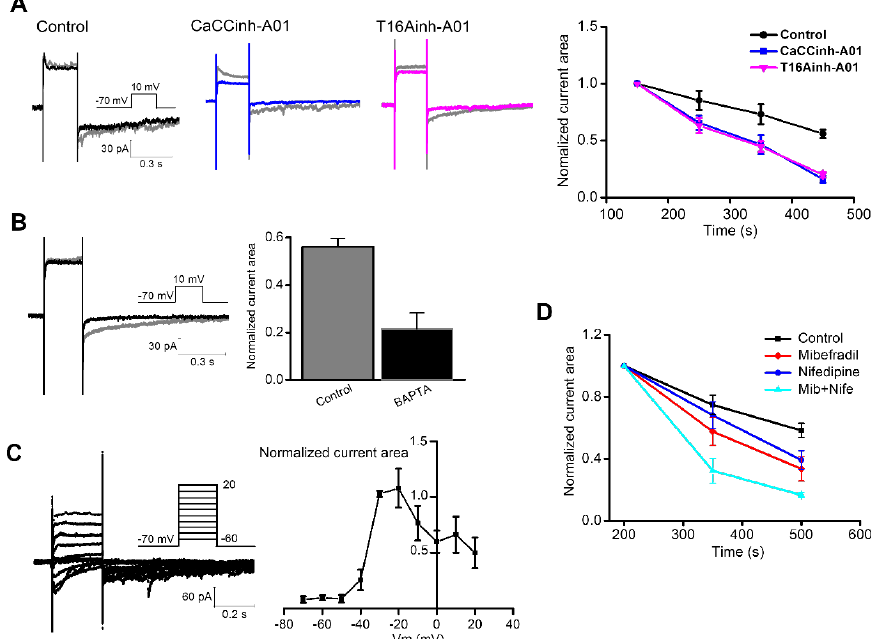
Figure 1. Relationship between Ca 2 + -dependent characteristics of the TMEM16A / anoctamin1 (ANO1) current and voltage-gated Ca 2 + channel (VGCC). ( A ) Rod bipolar cells were stimulated from a holding potential of − 70 mV to a membrane potential 10 mV for 250 ms. Representative current traces before (gray) and 300 s after drug administration (black, blue, pink). The current area was normalized by the area of I tail at 150 s, and the normalized current area over time (right) showed the inhibitory e ff ect of ANO1-specific blockers ( n = 7; p < 0.05, Student’s t -test). ( B ) Internal application of 5 mM BAPTA (black; 0.56 ± 0.03) decreased I tail compared with the control (gray; 0.21 ± 0.06; n = 7; p < 0.05, Student’s t -test). ( C ) Rod bipolar cells were stimulated from a holding potential of − 70 to − 60 mV until approximately 20 mV. Current traces (left) and the normalized current area of I tail (right) against command voltage were plotted. ( D ) The current area was normalized by the area of I tail at 200 s, and the normalized current area over time showed the inhibitory effects of L- and T-type VGCC inhibitors, namely 40 μM nifedipine and 40 μM mibefradil, respectively ( n = 7; ANOVA, p < 0.05).